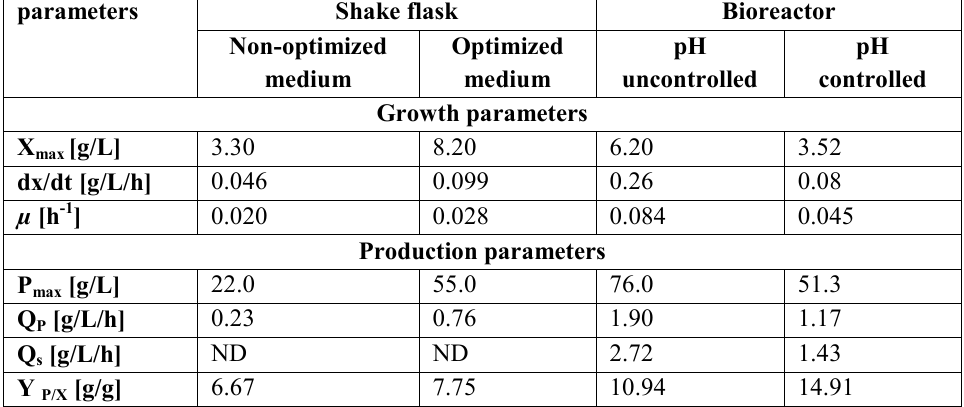
Table 1. Kinetics of cell growth and acetic acid production in shake flasks and in bioreactor using different media and under cultivation